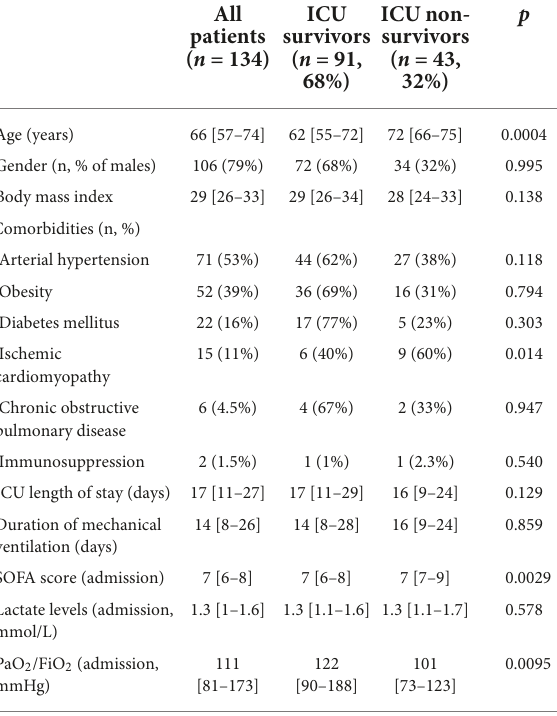
TABLE 1 General characteristics of the included patients. TABLE 2 Comparison of all arterial blood gases with or without hyperoxemia (PaO 2 > 100